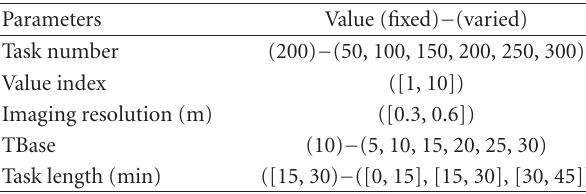
Table 2: Parameters for task simulation.